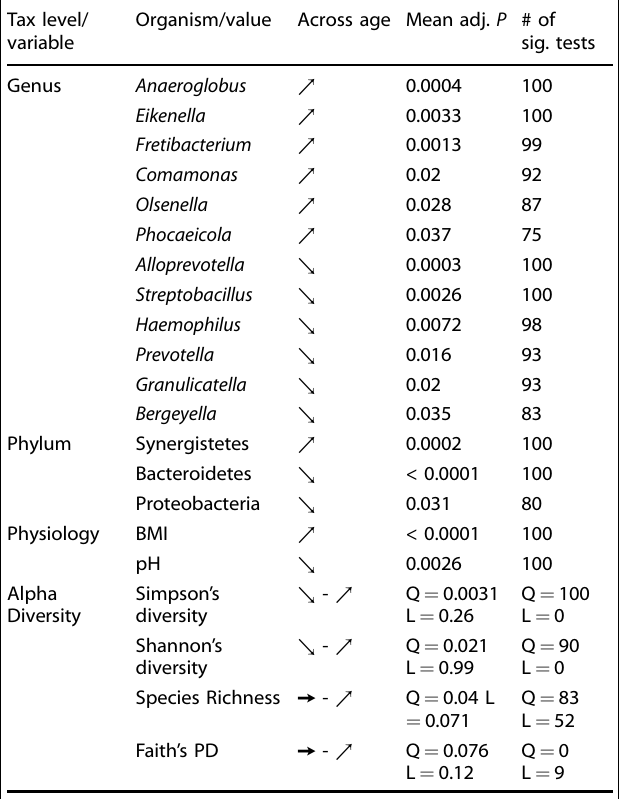
Table 1. Signi fi cance of differentially abundant taxa and alpha diversity measures as age